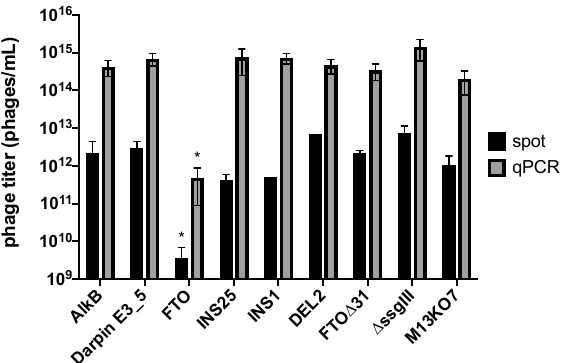
Figure 6. Effects of display on phage production as measured by spot titration and qPCR. FTO phage titers were compared with those of AlkB and Darpin E3_5 [15] display phages, FTO indel variants (INS25, INS1, DEL2, FTO ∆ 31), and phagemid-containing particles lacking the complete FTO-ssgIII fusion gene ( ∆ ssgIII), and M13KO7 helper phage. Data are the means of at least two biological and three technical replicates (except spot titer of INS1 and DEL2). For both methods, the FTO phage titer is ~10 3 times lower than all other titers (indicated by *; p < 0.05). Reduced amplification of full-length FTO-displaying phage particles, as a result of both reduced host cell growth and reduced phage production, can explain the false-posi- tive biopanning results. In mixed cultures, out-of-frame or FTO truncation mutants am- plify more efficiently by avoiding productive FTO-G3P expression (Figure 5). As a result, genuine affinity-selected FTO clones risk being outcompeted during host cell growth and phage rescue by parasitic clones which enrich independent of target binding.